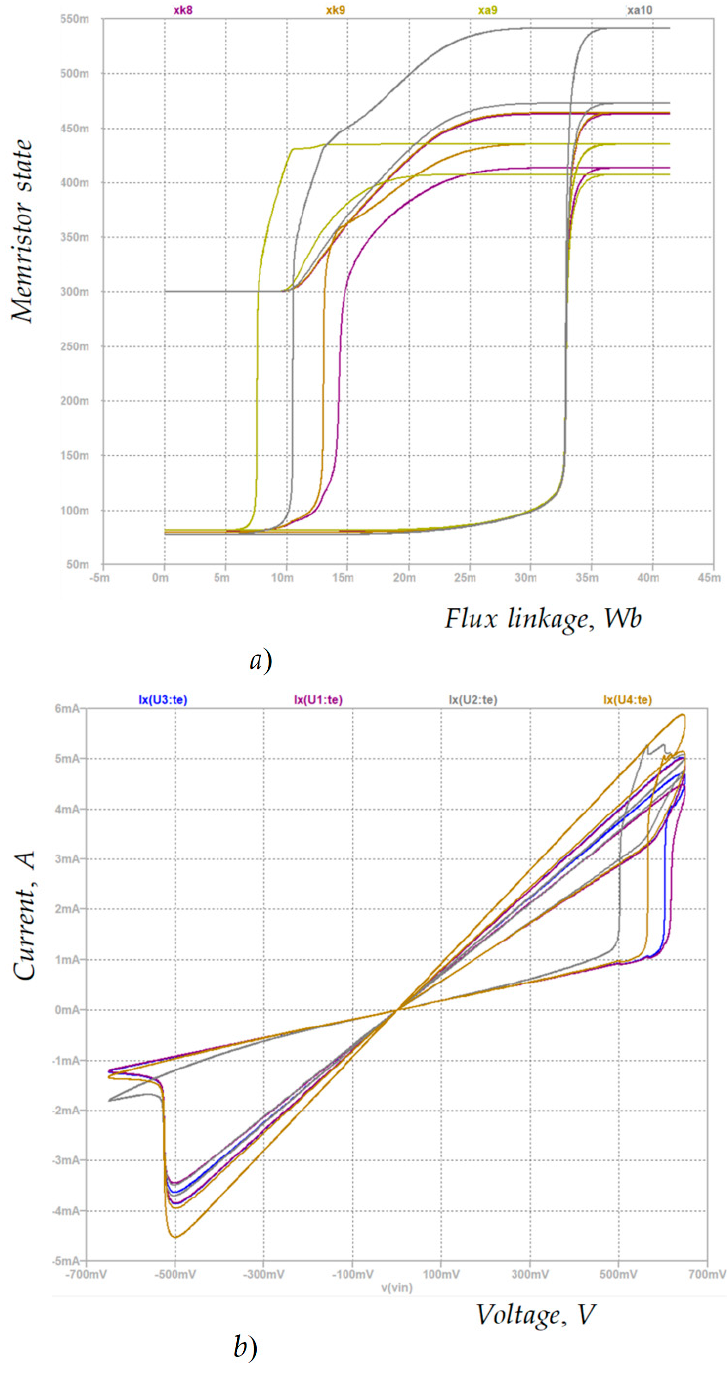
Figure 5. ( a ) State–flux relationships of the standard tantalum oxide memristor models K 8 and K 9 , and the modified models A 9 and A 10 with a sinusoidal voltage magnitude of 0.65 V and frequency of 5 Hz; ( b ) The corresponding current–voltage relationships of the considered tantalum oxide memristor